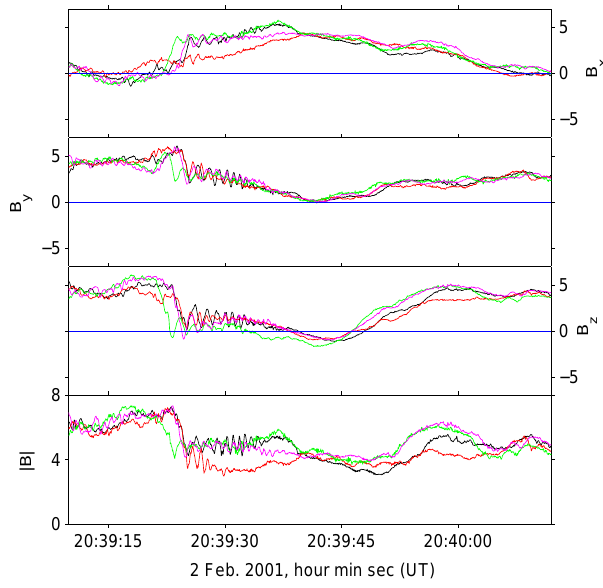
Fig. 11. Magnetic field data at 22 vectors/s in GSE coordinates, in the same format at Fig. 5. The data show a shocklet with an upstream whistler